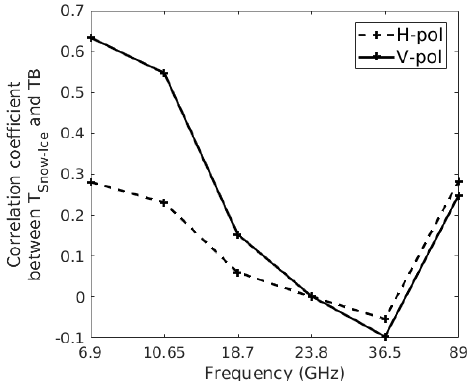
Figure 5. Correlation coefficient between the T Snow − Ice from IMBs and the AMSR2 TBs, as a function of AMSR2